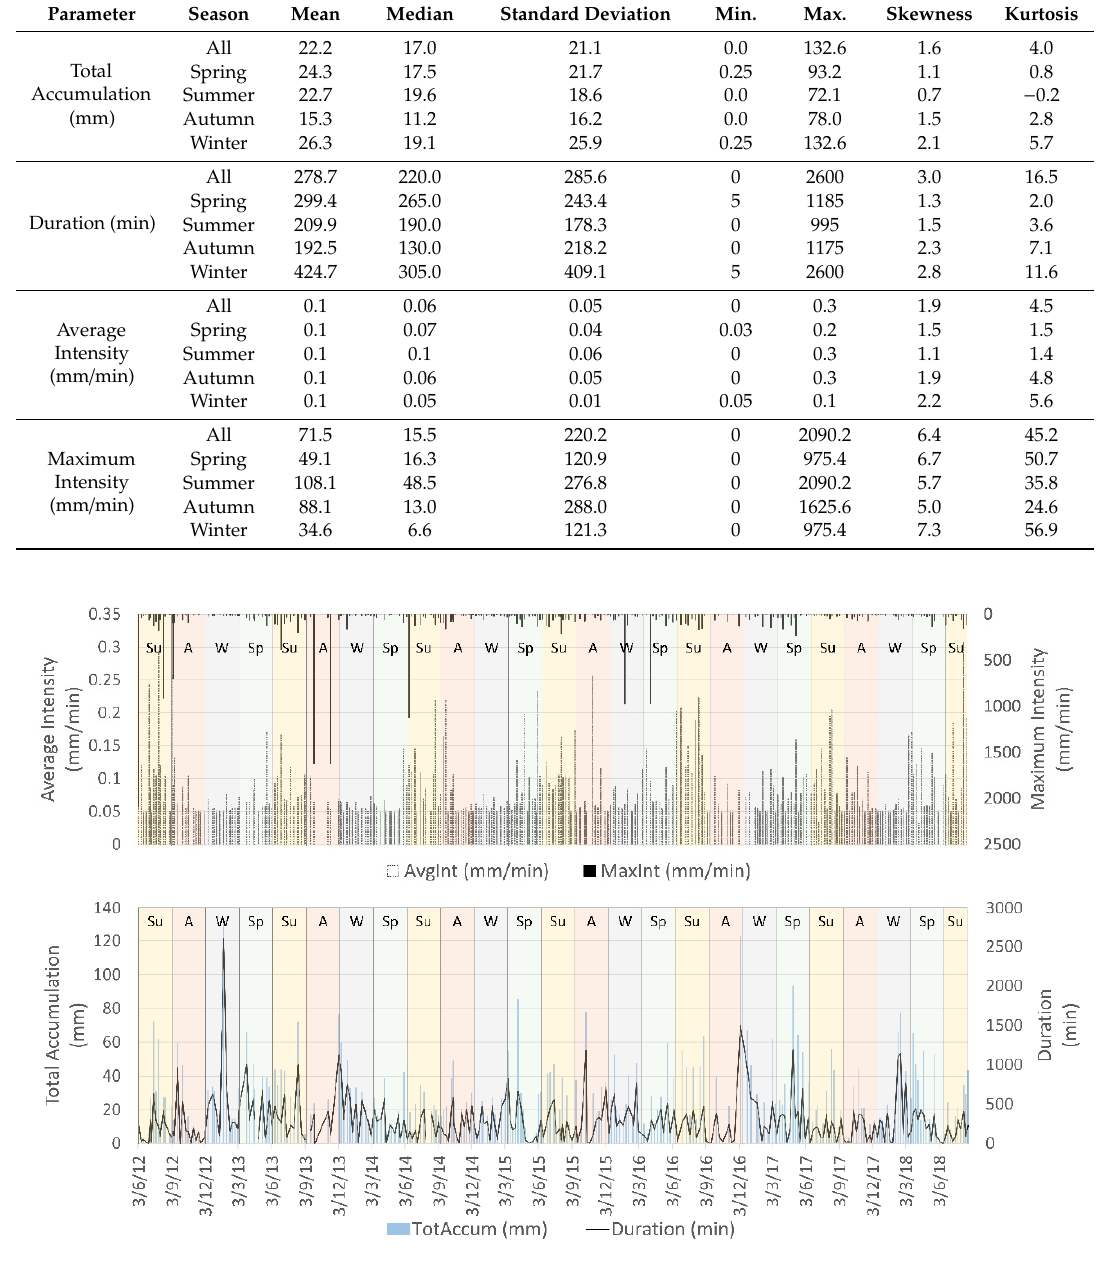
Figure 2. Time series of precipitation parameters. AvgInt and MaxInt refer to average and maximum precipitation intensity, respectively. TotAccum is the total depth of precipitation received during each weekly measurement period, and Duration is the total minutes during which precipitation was measured, for each measurement period. Columns delineate seasons (Su = summer, A = autumn, W = winter, and Sp = spring).